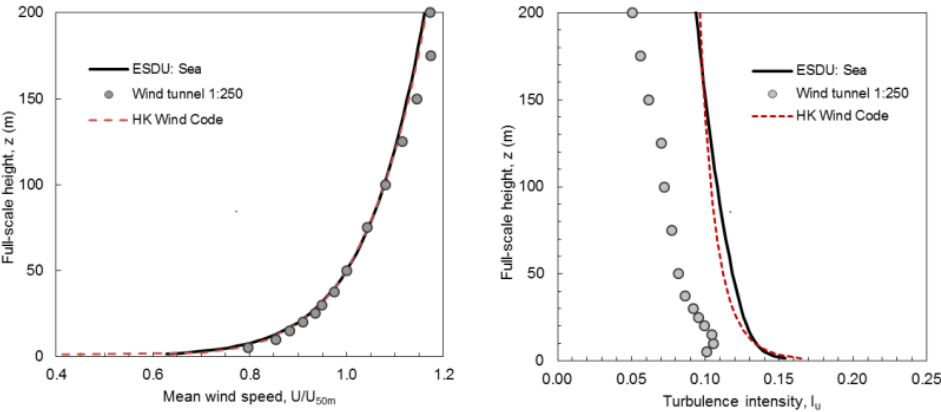
Figure 1. Vertical profiles of mean wind speed and longitudinal turbulence intensity simulated in wind tunnel.